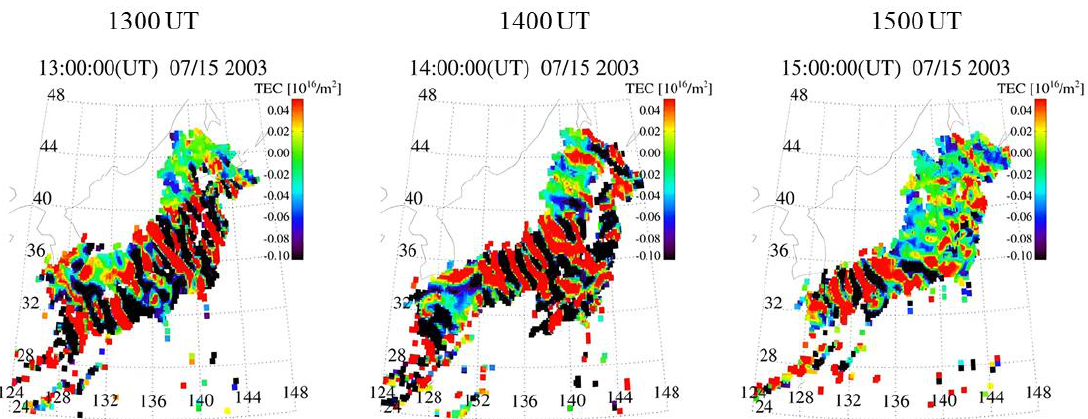
Figure 11. Detrended total electron content (TEC) maps over Japan (https://aer-nc-web.nict.go.jp/GPS/GEONET/ (accessed on 20 January 2023)) from 13 to 15 UT on 15 July 2003. The detrended TEC maps are obtained using a 15 min running window.